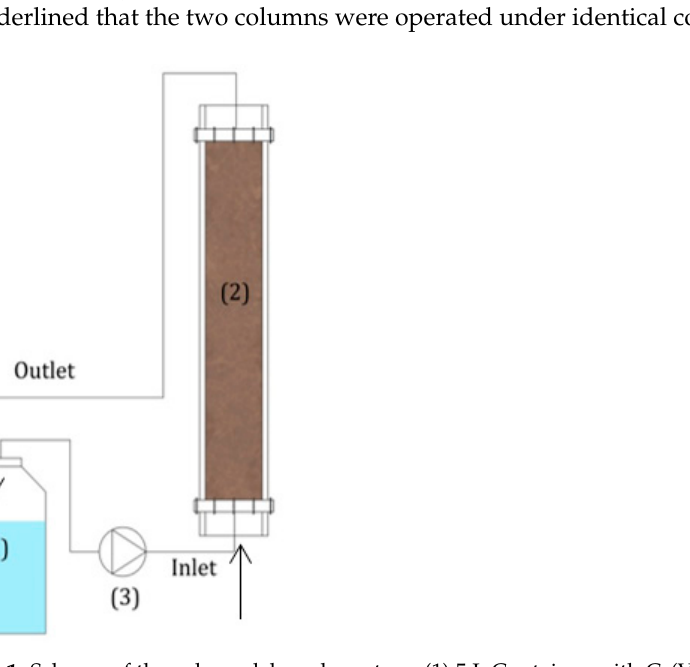
Figure 1. Scheme of the column lab-scale system: (1) 5 L Container with Cr(VI) solution, (2) Column filled with soil, (3) Peristaltic pump.